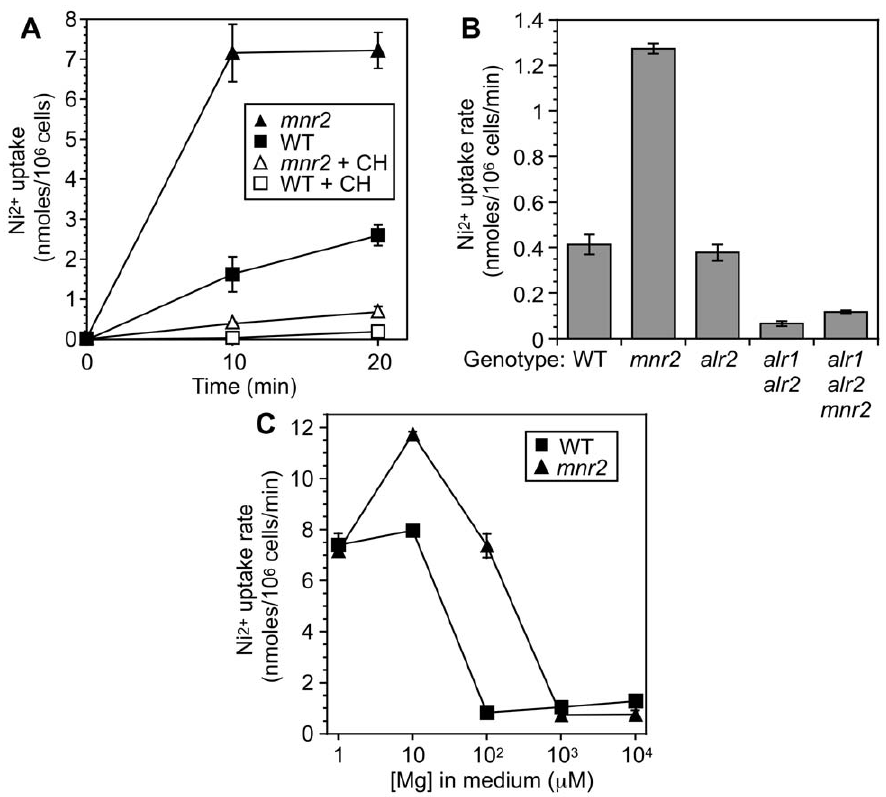
Figure 1. Effect of Mg supply and the mnr2 mutation on Alr system activity. ( A ) Effect of cobalt(III)hexaammine chloride (CH) on Ni 2 + uptake activity. WT (DY1457) and mnr2 (NP4) strains were grown to log phase in YPD medium. At zero time, cells were added to uptake buffer containing 100 m M NiCl 2 , with or without 100 m M CH inhibitor. At the indicated times, aliquots were removed and processed for measurement of nickel content by ICP-MS, as described in Materials and Methods. ( B ) Rate of CH-inhibited Ni 2 + uptake by WT (DY1457), mnr2 (NP4), alr2 (NP27), alr1 alr2 (NP14) and alr2 alr2 mnr2 (NP20) strains. Assays were performed as described in (A), except strains were grown to log phase in YPD + 50 mM MgCl 2 . Nickel content was determined zero and 5 min after addition of 100 m M NiCl 2 , and initial Ni 2 + content subtracted from 5 min values. ( C ) Regulation of the Alr systems by Mg supply. DY1457 (WT) and mnr2 (NP4) strains were grown to log phase in SC medium, washed to remove excess Mg, and incubated for 6 h in LMM with the indicated Mg concentration. Cells were washed, resuspended in uptake buffer, and incubated with 100 m M Ni 2 + for 1 min. Initial Ni 2 + content was subtracted from 1 min values to give the results shown. For all graphs, values are means of four replicates, and error bars indicate + / 2 1